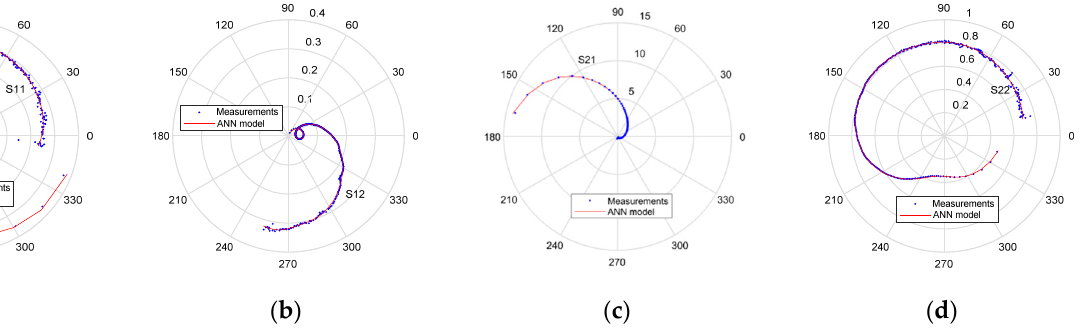
Figure 13. Measured (blue symbols) and ANN simulated (red lines) behavior of ( a ) S 11 , ( b ) S 12 , ( c ) S 21 , and ( d ) S 22 with the frequency range spanning from 200 MHz to 65 GHz for the DUT at V DS = 30 V, V GS = − 3.1 V, and T a = 200 °C.